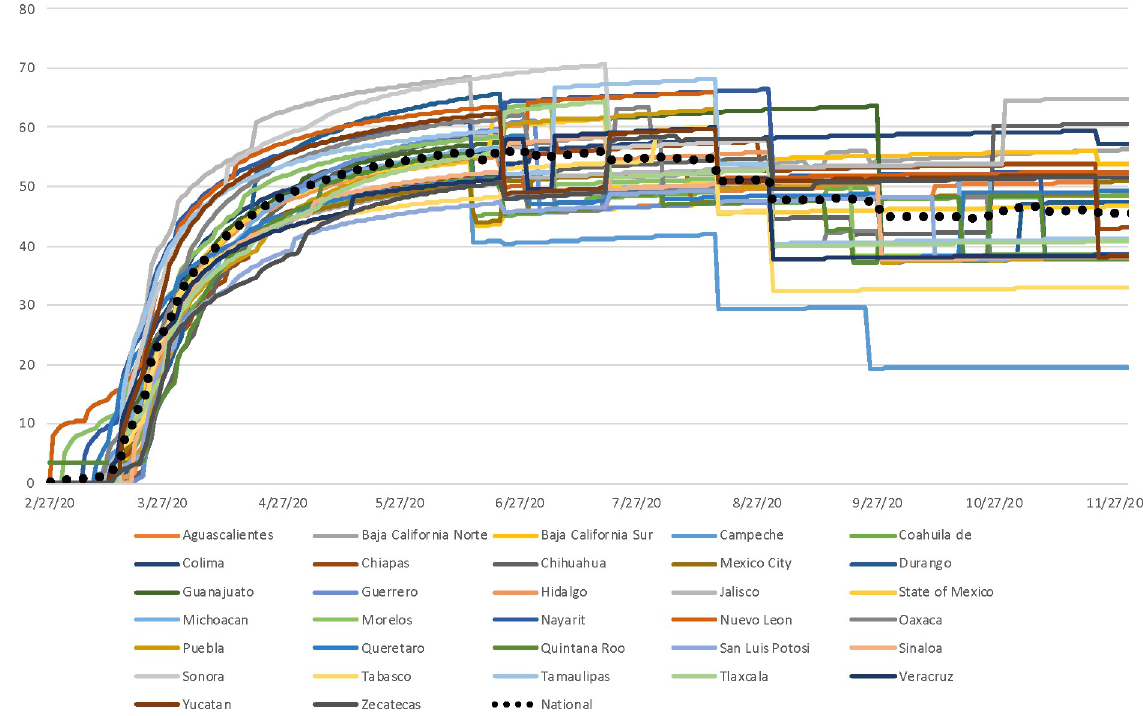
Fig 1. Public policy index for the containment of COVID-19 in Mexico. From February 27, 2020 to November 30, 2020.